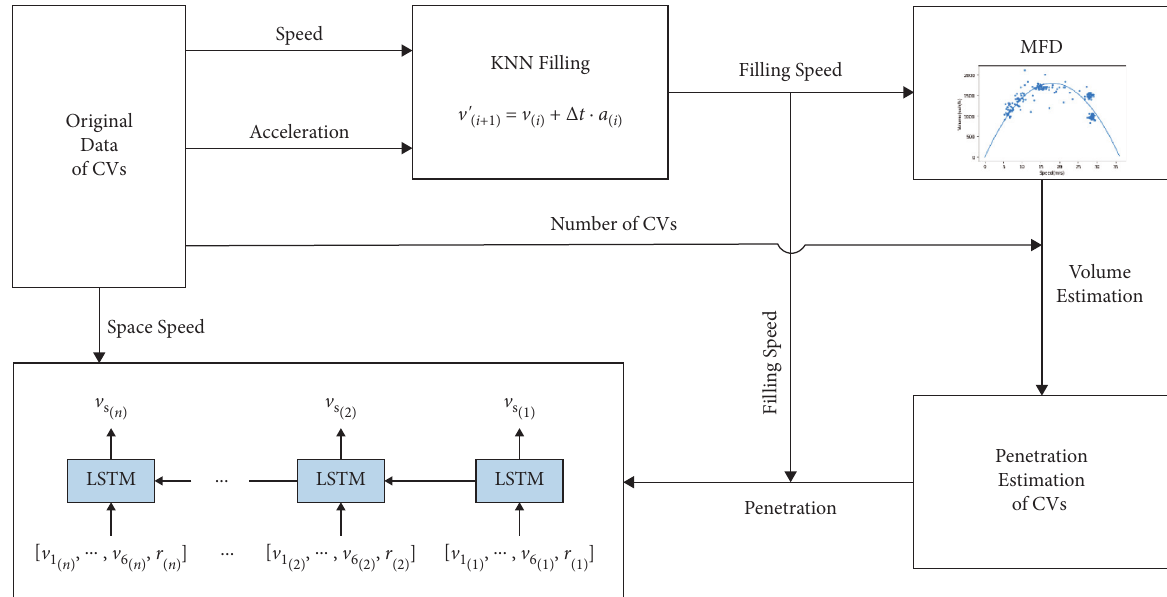
Figure 1: ACC-P-LSTM model